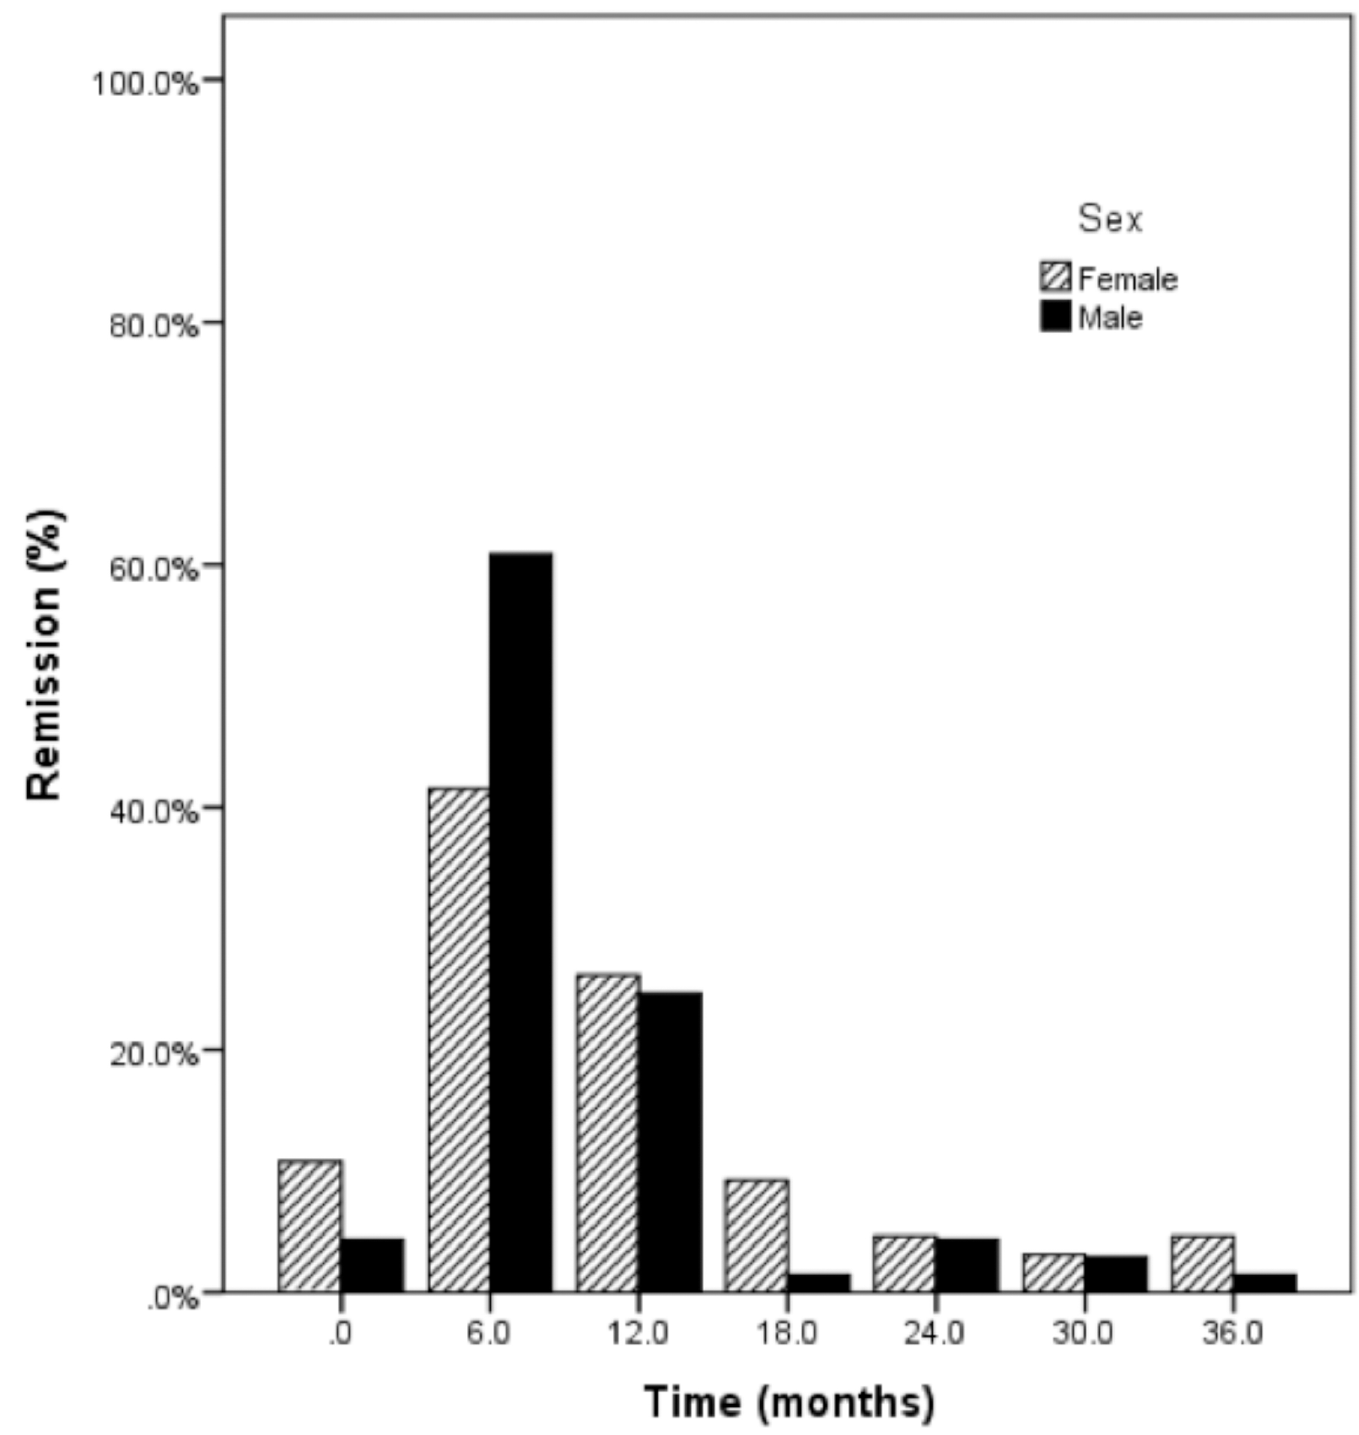
Fig 1. Bar graph of the prevalenceof remission at different time points in male and female pediatric subjects with new-onset type 1 diabetes.